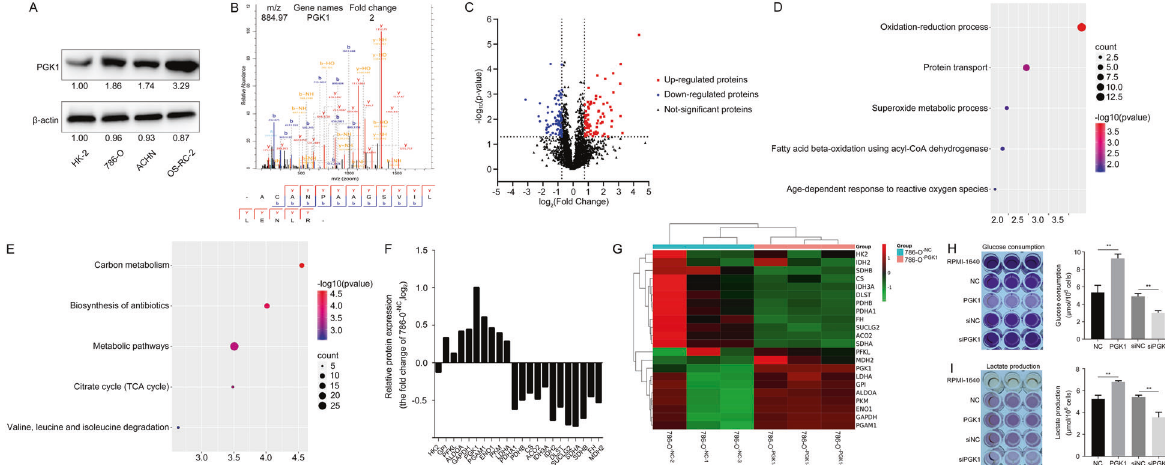
Fig. 3 Comparison of proteomic pro fi les between KIRC cells with stably expressing PGK1 and mock transfection cells by LC-MS/MS quanti fi cation. A The endogenous protein levels of PGK1 were detected in 3 human KIRC cell lines and renal tubular epithelial HK-2 cell line. B MS/MS spectrum of PGK1 was presented. C DEPs were identi fi ed from 786-O -PGK1 cells compared to 786-O -NC cells. D , E DEPs were involved in the top fi ve most signi fi cantly biological processes and pathways. F , G PGK1-mediated expression changes of enzymes related to glycolysis and TCA cycle in 786-O cells. H , I PGK1 overexpression (suppression) signi fi cantly enhanced (decreased) glucose consumption and lactate production in KIRC cells. RC-2 (Fig. 3A). Among three RCC cell lines, PGK1 expression level was the highest in OS-RC-2, relatively lower in 786-O cells and the lowest in ACHN cells. Since we focused on the function of PGK1 in cancer cell activity, we chose to overexpress PGK1 in 786-O and ACHN cells with Cell Death and Disease (2022)